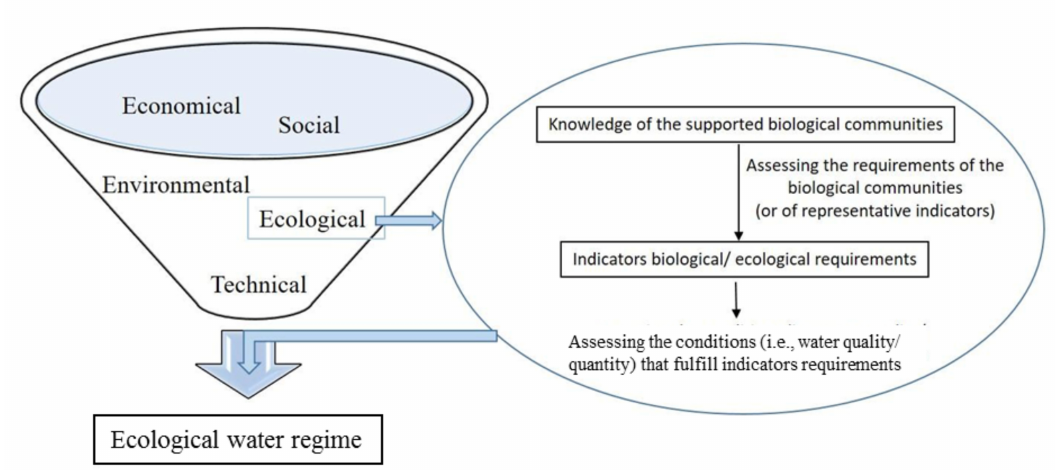
Figure 1. Simplified schematic view of the factors the trade-o ff s among which should be considered in assessing the ecological water regime of aquatic